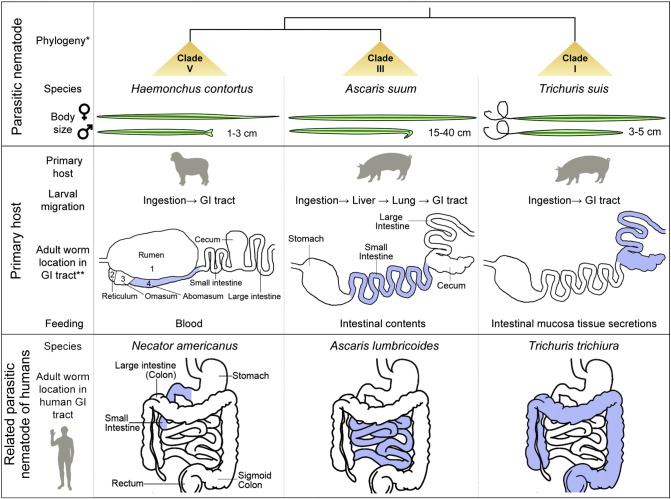
Characteristics of core species: phylogeny, host location and trophic ecology. *Phylogeny based on Blaxter et al., 1998. ** GI tract, gastro-intestinal tract.